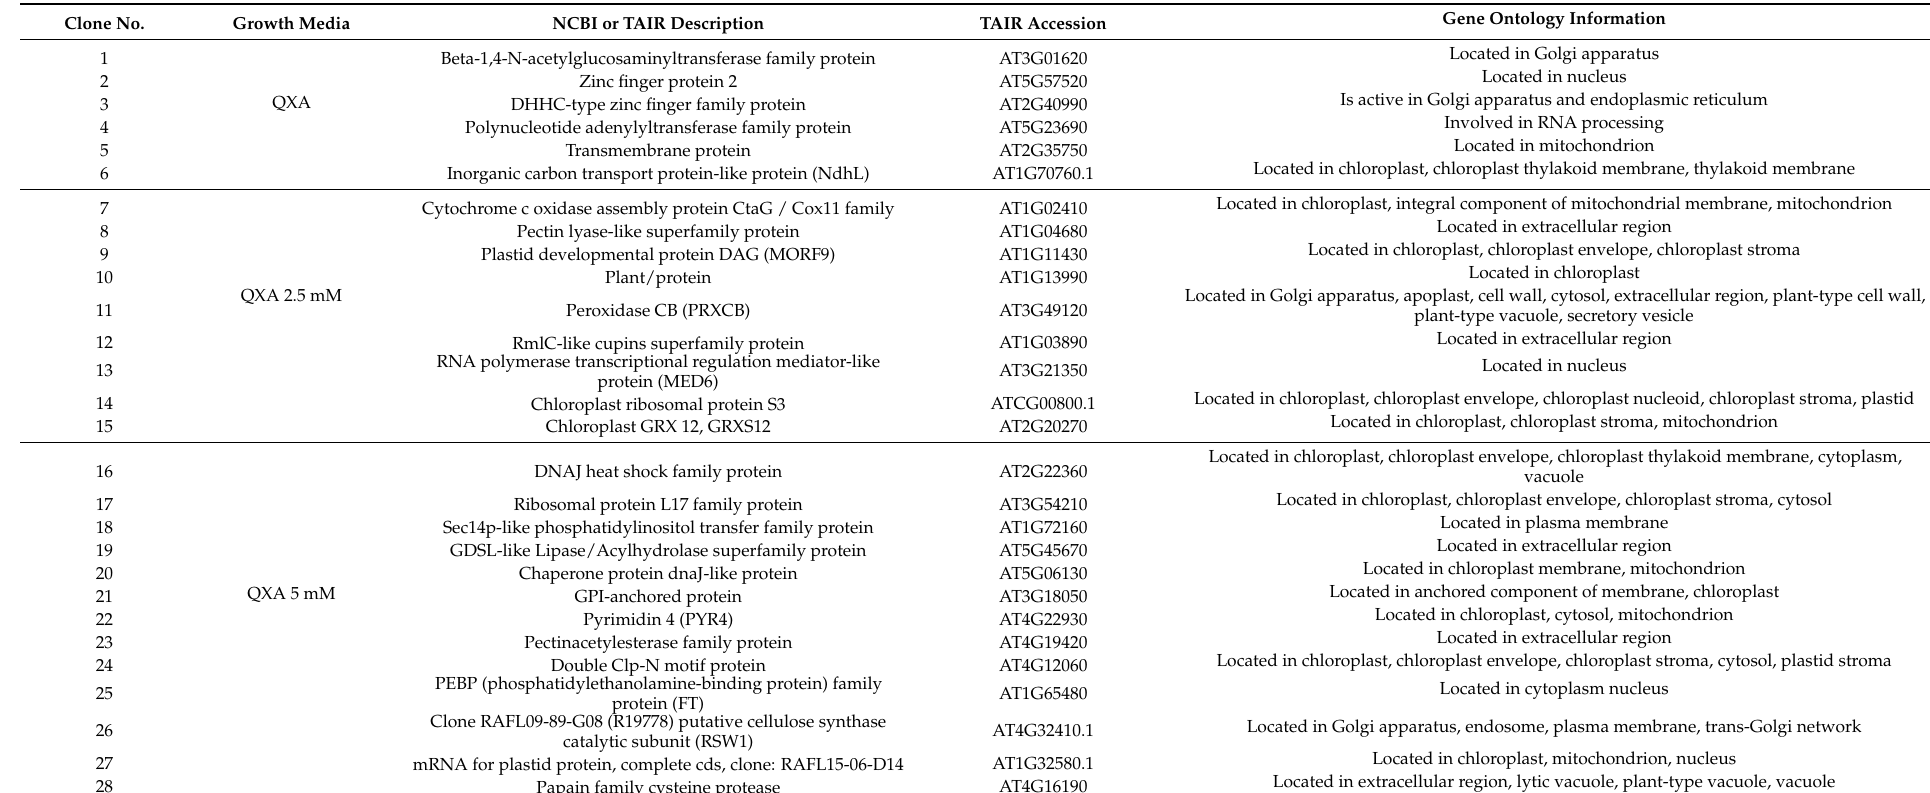
Table 1. Yeast two-hybrid-derived clones obtained from a screening using PMeV ORF1 fragment 4 (CP4) as bait. Clone